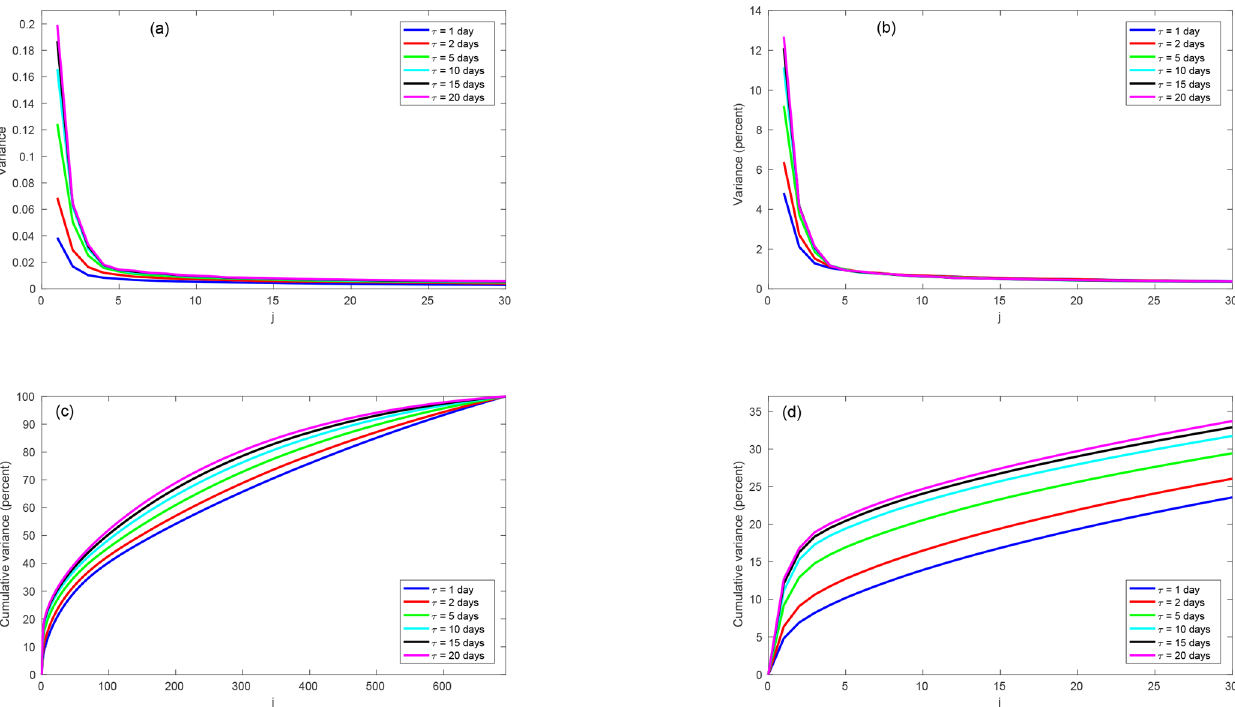
Figure 3. (a) Variance of the principal components of the finite-time Lyapunov fluctuations. (b) Fraction of variance. (c) Cumulative fraction of variance. (d) Close-up of (c)